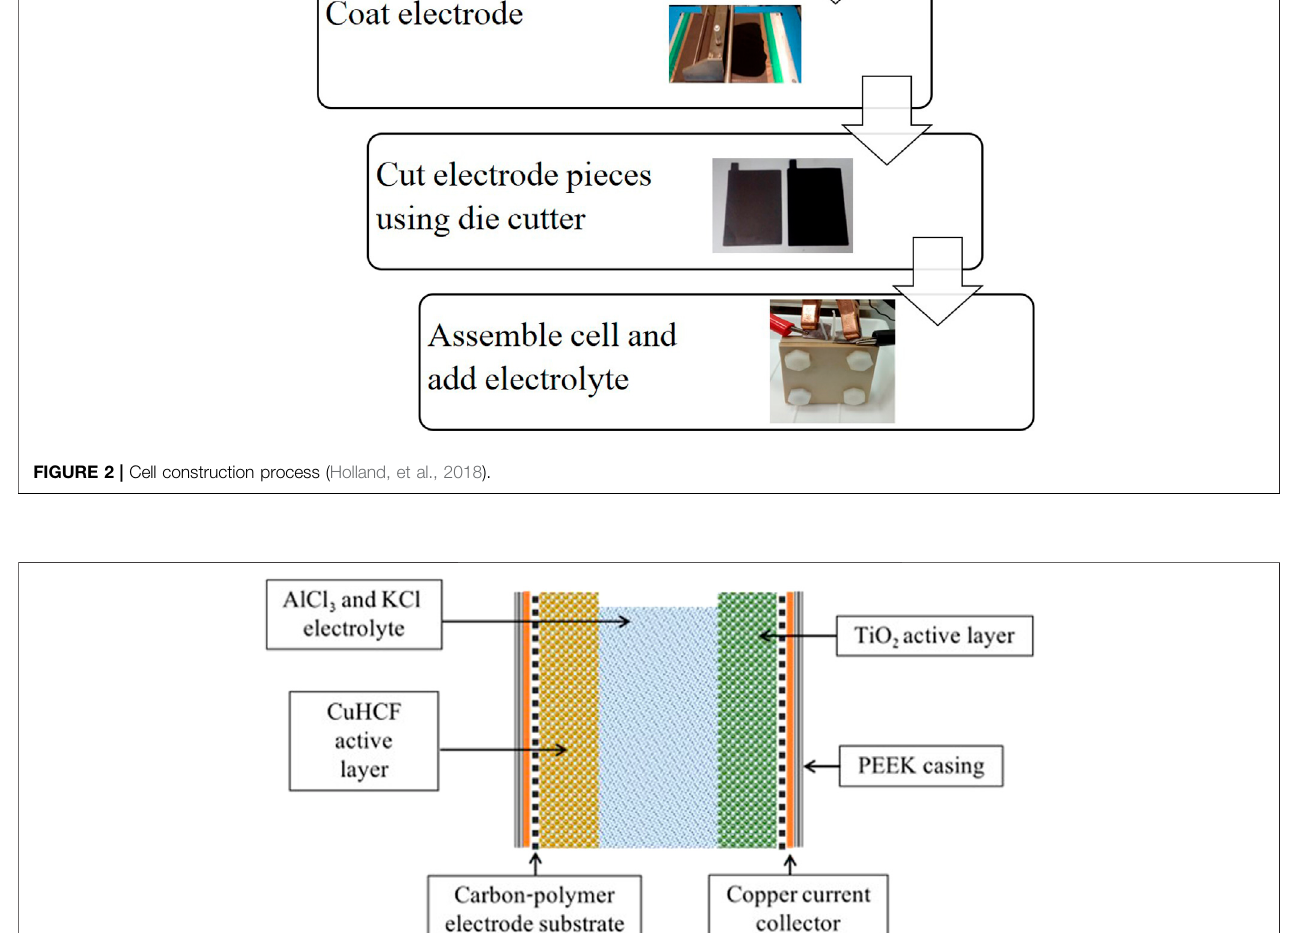
FIGURE 3 | Cross section of the assembled